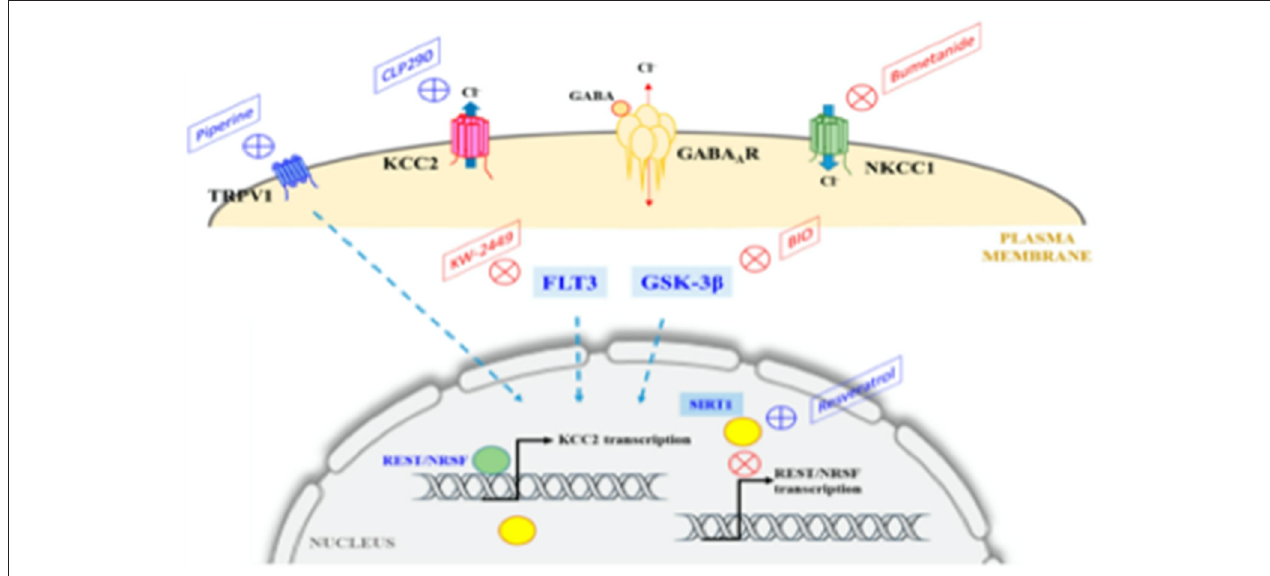
FIGURE 7 | A schematic diagram illustrating the major chloride transporters KCC2 and NKCC1, whose activities determine intracellular Cl—concentration and EGABA, and the pharmacological manipulations that could potentially correct for a loss of KCC2 levels or activity under neuropathological conditions (where GABAergic transmission could become excitatory instead of inhibitory). The classical NKCC1 antagonist bumetanide has been shown to be efficacious in this regard. As discussed in the text, CLP290 enhances the plasma membrane expression of KCC2, while compounds that target TRPV1, FLT3, or GSK-3 β also modulates KCC2 expression (dotted arrows), but the mechanisms involved are unclear. Resveratrol activation of SIRT1 could downregulate the expression of RE1-silencing transcription factor/Neuron-restrictive silencer factor (REST/NRSF), which suppresses KCC2 expression (